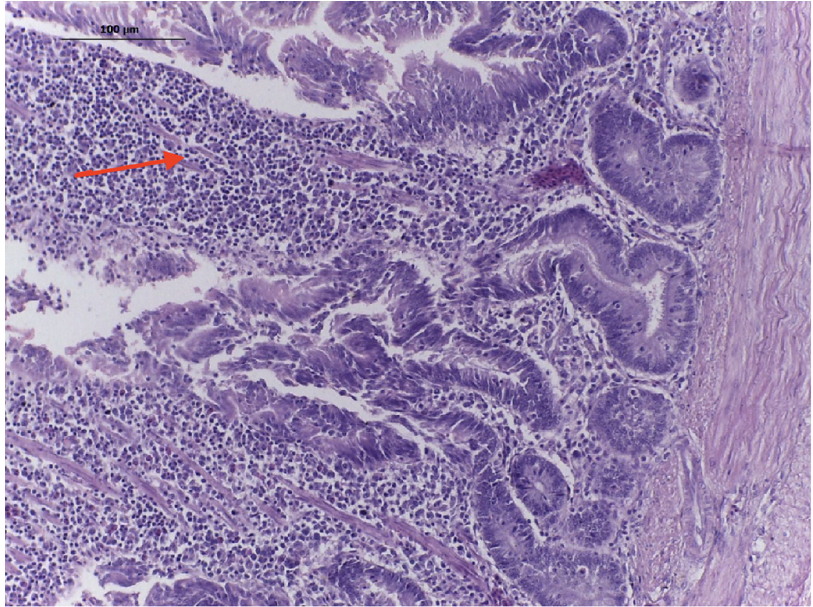
Figure 3. Micrograph of a chicken intestine, four days after the inoculation of A. butzleri AB170 strain, presenting inflammatory infiltrate cells (Red arrow). HE × 100.